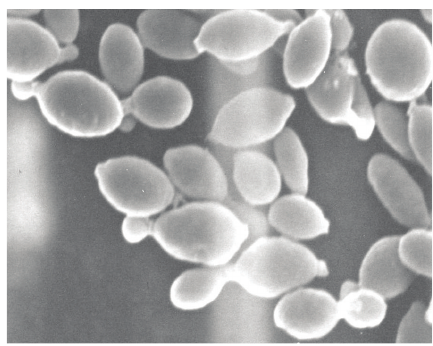
Figure 2: Scanning electron micrograph of S. elviae grown on malt extract broth showing separation of yeast cells by septa